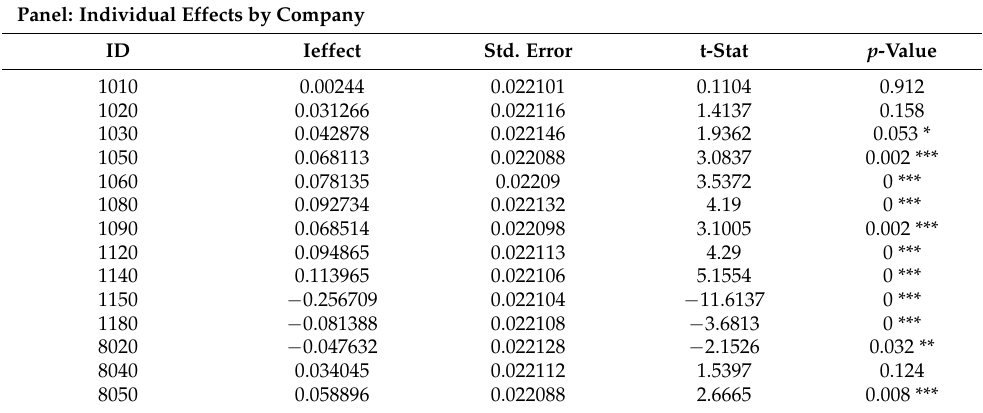
Table A2. Relationship between extra return, oil and trading volumes during the COVID-19 pandemic. Panel: Individual Effects by